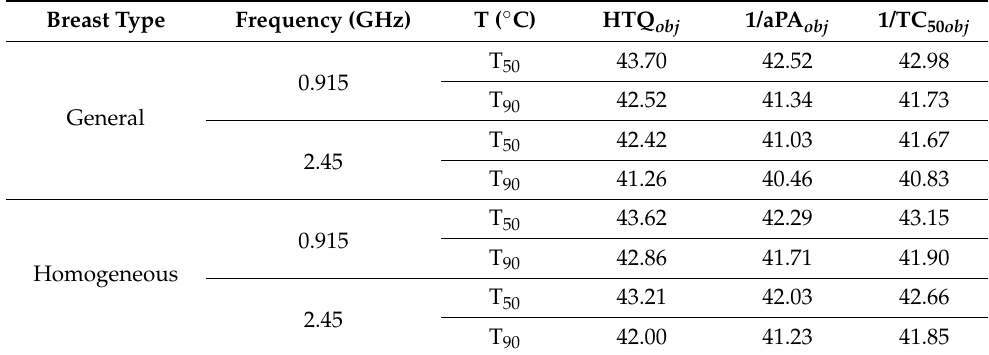
Table 8. Mean and standard deviation of damaged healthy tissue rate for two breast models using DE.